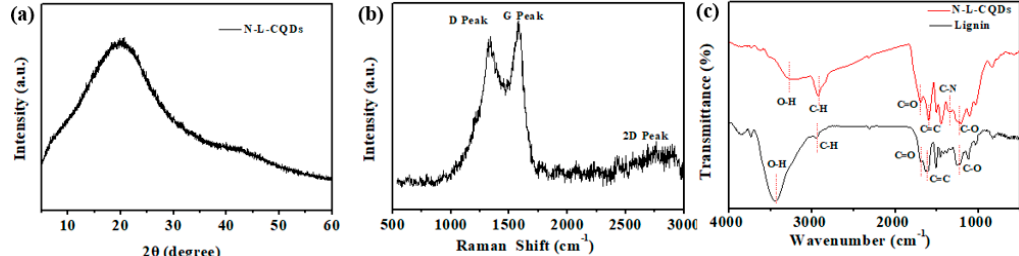
Figure 2. ( a ) XRD pattern of N-L-CQDs; ( b ) Raman spectrum of N-L-CQDs; and ( c ) FTIR spectra of N-L-CQDs.